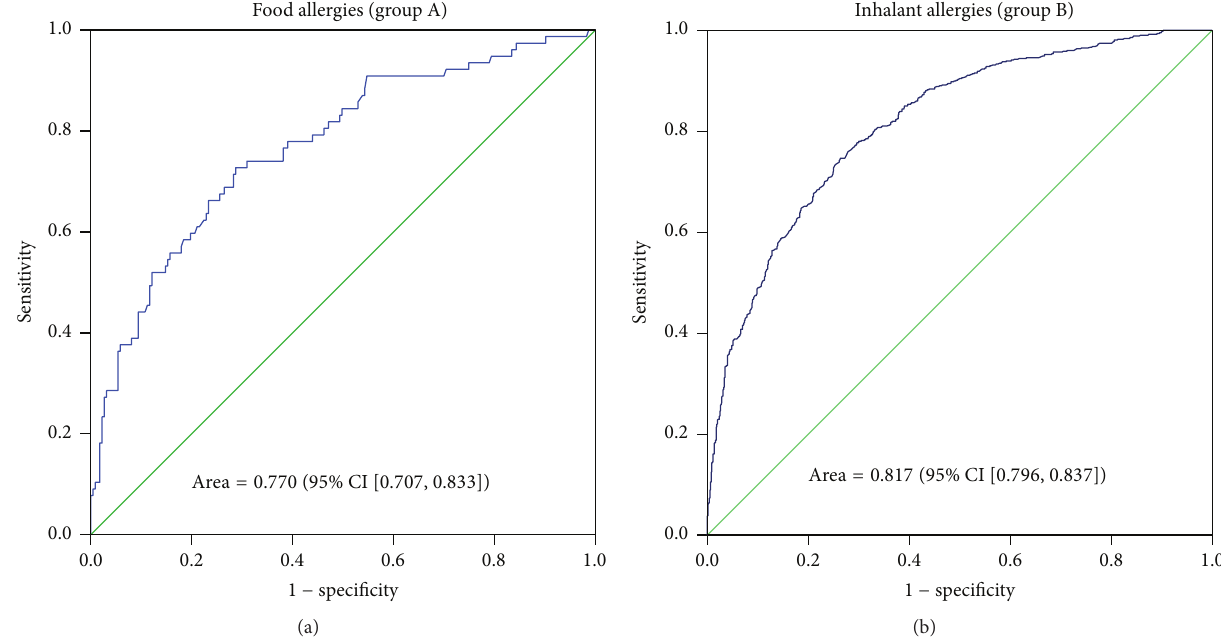
Figure 1: ROC curves for detecting patients with a food allergy (a) and an inhalant allergy (b) using total IgE testing. The area under the curve (AUC = 0.817, 95% CI [0.796, 0.837], 𝑝 < 0.001 ) is superior in case of inhalant allergy compared to that of food allergy (AUC = 0.770, 95% CI [0.707, 0.833], 𝑝 < 0.001 ).